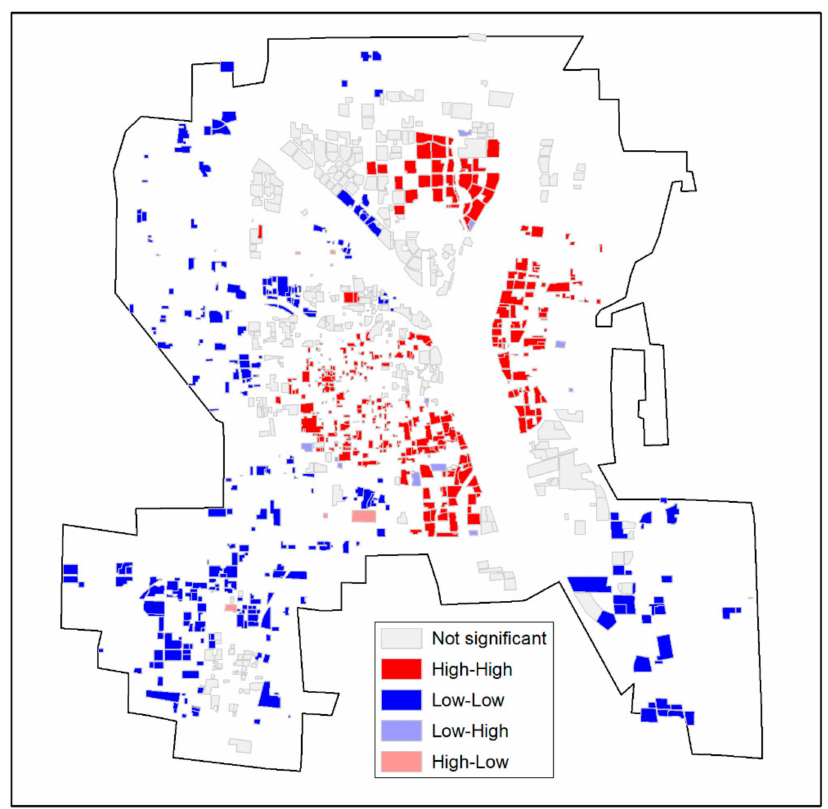
Figure 10. Spatial pattern of clusters of high and low livability scores. Clusters indicate that a high (low) livability score is surrounded primarily by high (low)